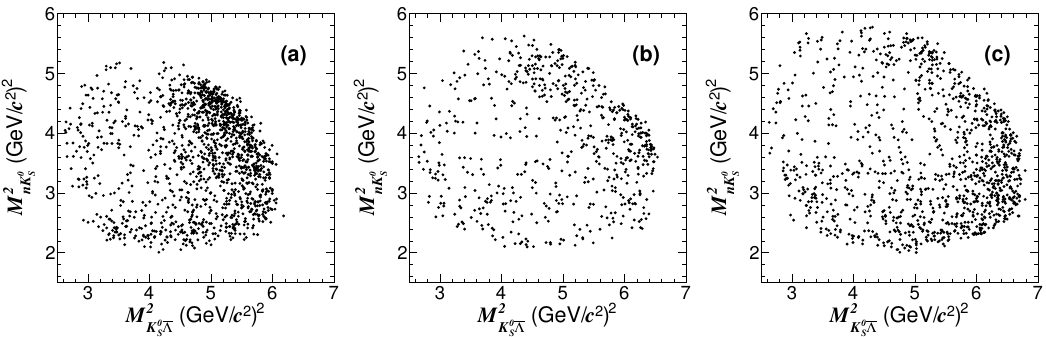
versus M 2 for the (a) χ c 0 , (b) χ c 1 , and (c) χ c 2 candidates in ¯Λ nK 0 K 0 S S ¯Λ for χ c 0 , χ c 1 , and χ c 2 are [3 . 39 , 3 . 45] , [3 . 50 , 3 . 53] , and nK 0 S